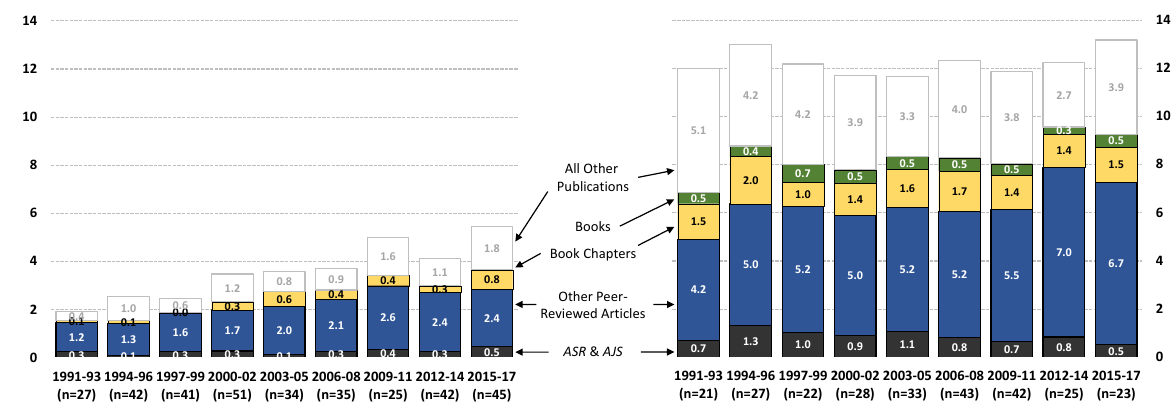
Figure 11: Mean number of first-authored publications by type and year. Shown are new assistant professors (left) and newly promoted associate professors